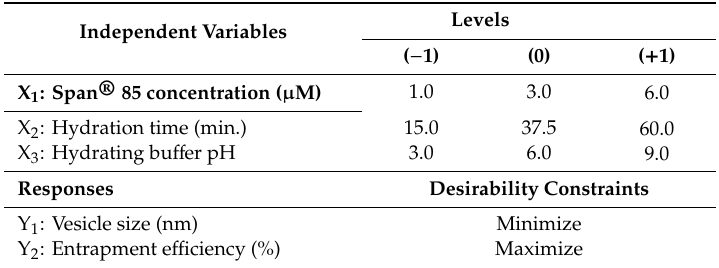
Table 1. Independent variables and responses used in the Box–Behnken design for the formulation and optimization of FLB